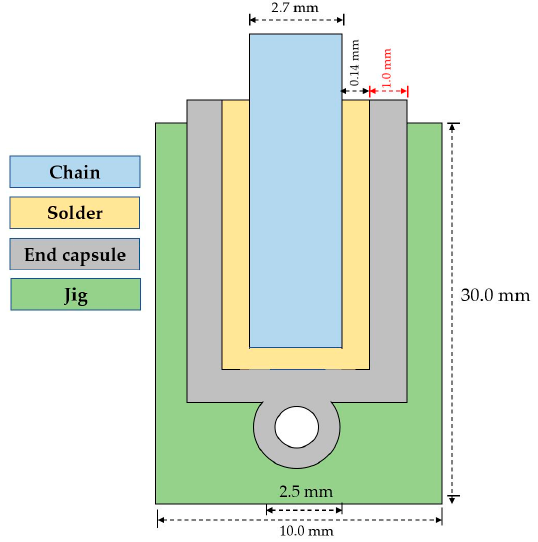
Figure 3. A 2D cross-section, material types and rough dimensions.